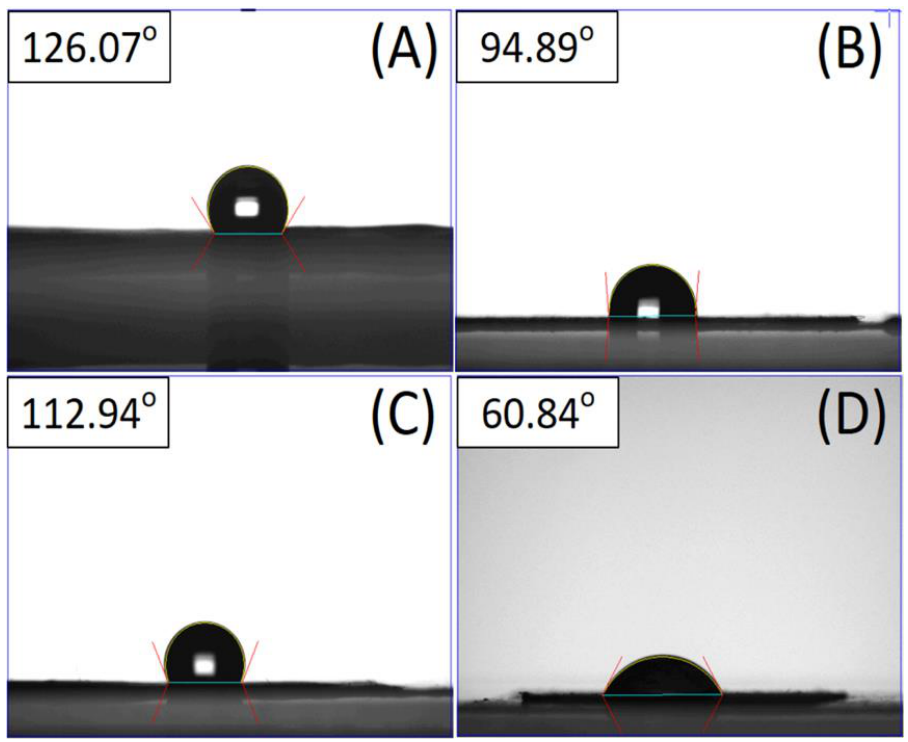
Figure 2. Wetting angles of ( A ) pristine PLGA nanofibers, ( B ) doxycycline-loaded nanofibers, ( C ) collagen-loaded nanofibers, and ( D ) bupivacaine-loaded nanofibers. The stress – strain curves of the spun nanofibrous mats were measured. The empirical data in Figure 3 illustrate that the DCB-composite nanofibers have a higher tensile strength and lower elongation at break than the pristine PLGA nanofibers.